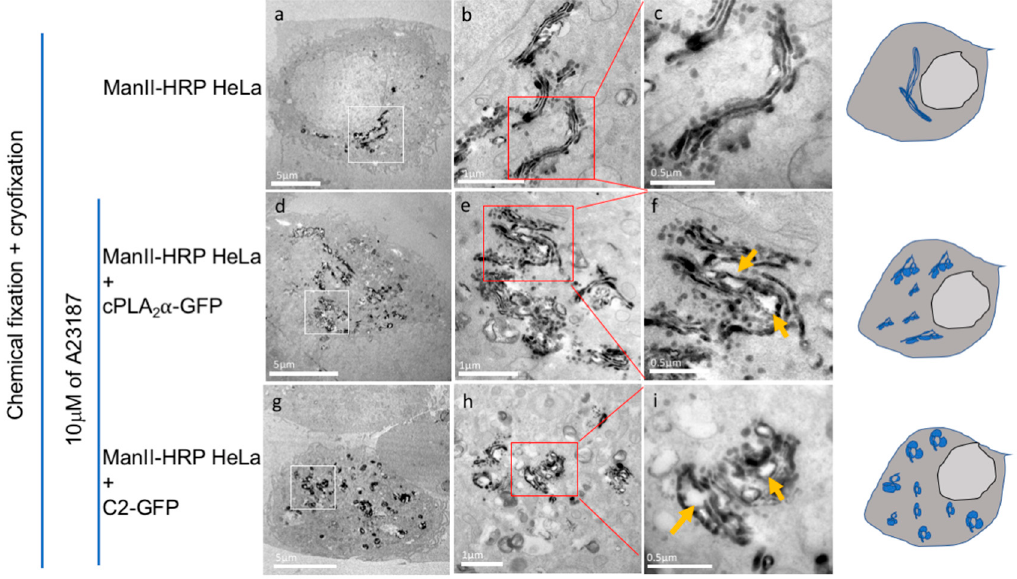
Figure 7. Ectopic cPLA 2 α and / or C2 domain expression in the presence of A23187 induces vacuolization, fragmentation, and dispersion of the Golgi apparatus. ( a – c ) A HeLa stable cell line expressing mannosidase-II-HRP was used to image changes in Golgi apparatus